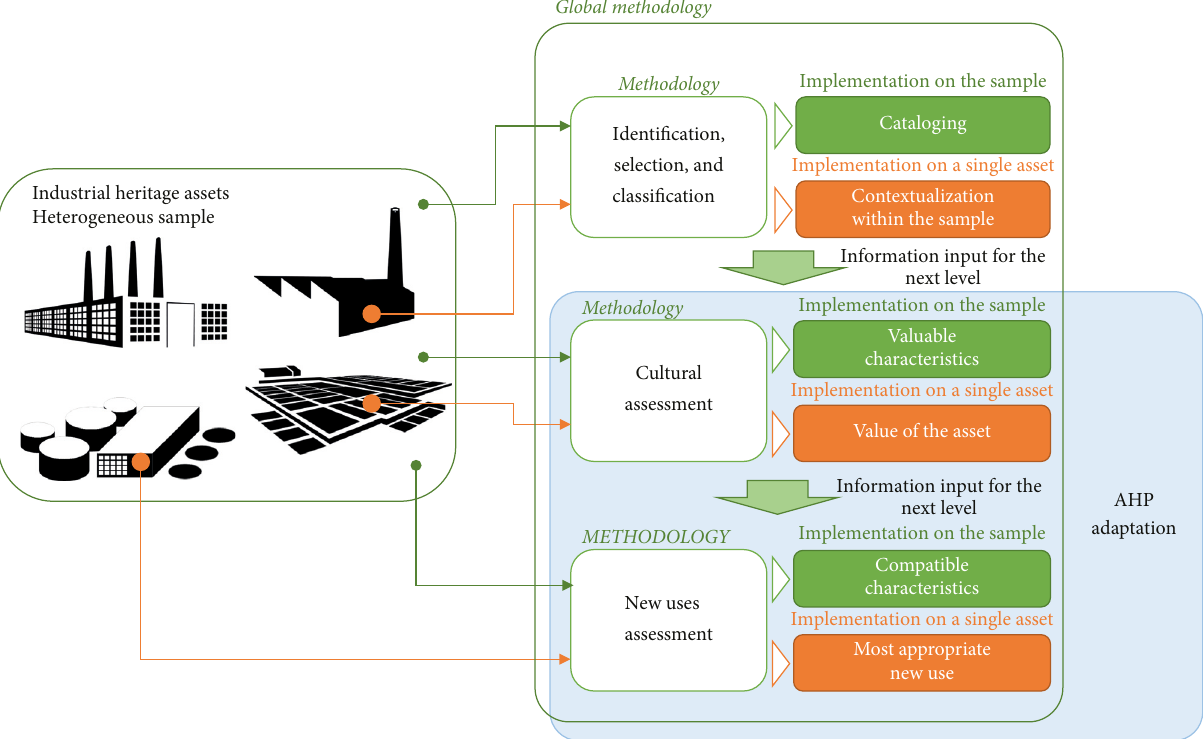
Figure 1: Integration of the partial methodologies in the global methodology